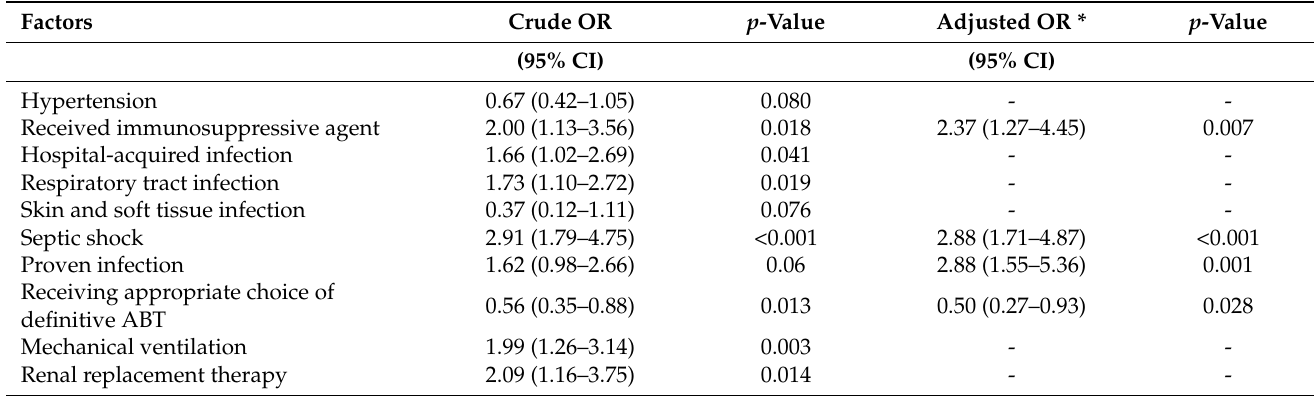
Table 4. Multivariate analysis for factors independently associated with 28-day mortality in patients with sepsis or septic shock.